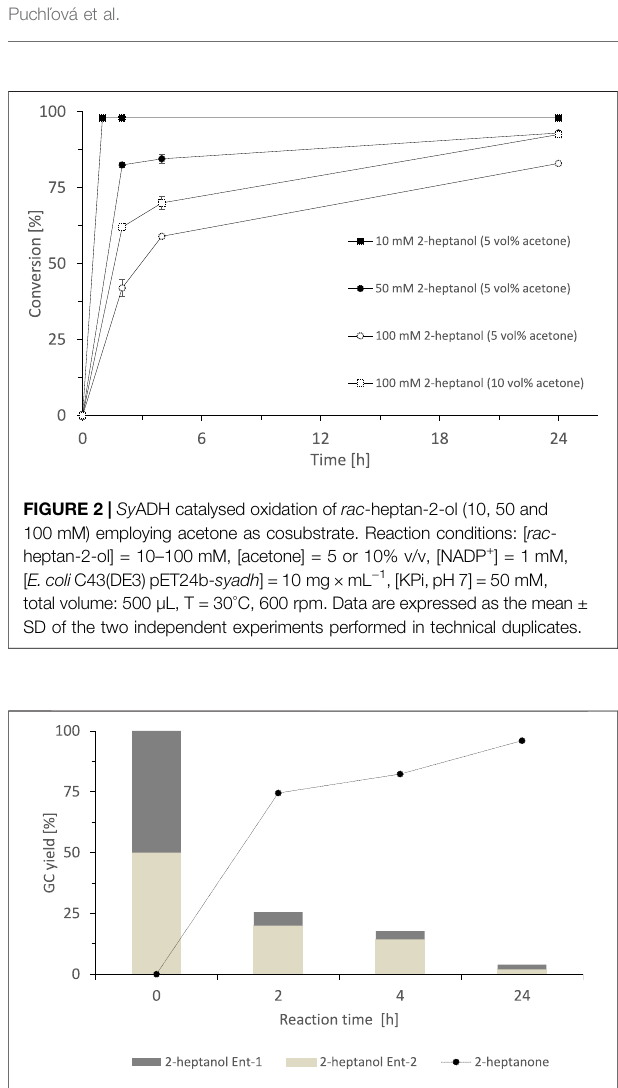
FIGURE 3 | Stereochemical course of the oxidation of rac -heptan-2-ol catalysedbythe Sy ADH-wholecellcatalyst.Reactionconditions:[ rac -heptan- 2-ol] = 50 mM, [acetone] = 10% v/v, [NADP + ] = 1 mM, [ E. coli C43(DE3) pET24b- syadh ] = 10 mg × mL − 1 , [KPi, pH 7] = 50 mM, total volume: